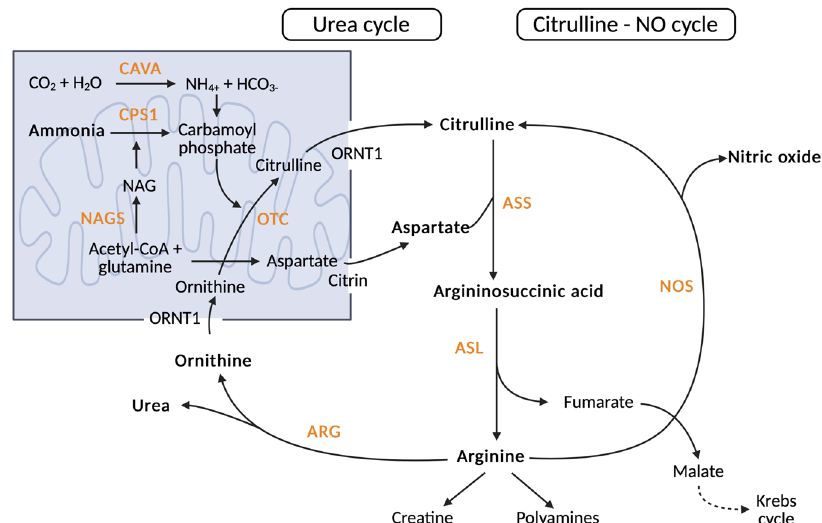
Fig. 1 The urea and citrulline-nitric oxide cycles. Ammonia is converted to urea via fi ve consecutive enzymatic reactions within the liver. The urea cycle begins in the mitochondria (blue box), where ammonia and bicarbonate are converted into carbamoyl phosphate. Carbamoyl phosphate requires allosteric activation by N-acetylglucosamine (NAG). Ornithine transcarbamylase (OTC) then catalyses formation of citrulline from carbamoyl phosphate and ornithine. Citrulline is channelled out of the mitochondria via the ornithine transporter (ORNT1), whilst citrin transports aspartate from the mitochondria to the cytoplasm. Argininosuccinate synthetase then enables the synthesis of argininosuccinate from citrulline and aspartate. Argininosuccinate is subsequently broken down into arginine and fumarate by argininosuccinate lyase, with fumarate directed to the Krebs cycle. Arginine is broken down into urea and ornithine by arginase. Ornithine is transported into the mitochondria by the ORNT1 transporter. CA5A carbonic anhydrase VA, CPS1 carbamoyl phosphate synthetase 1, NAG N-acetyl glutamate, NAGS N-acetyl glutamate synthase, OTC ornithine transcarbamylase, OTC1 ornithine transporter, ASS argininosuccinate synthetase, ASL argininosuccinate lyase, ARG arginase, NOS nitric oxide